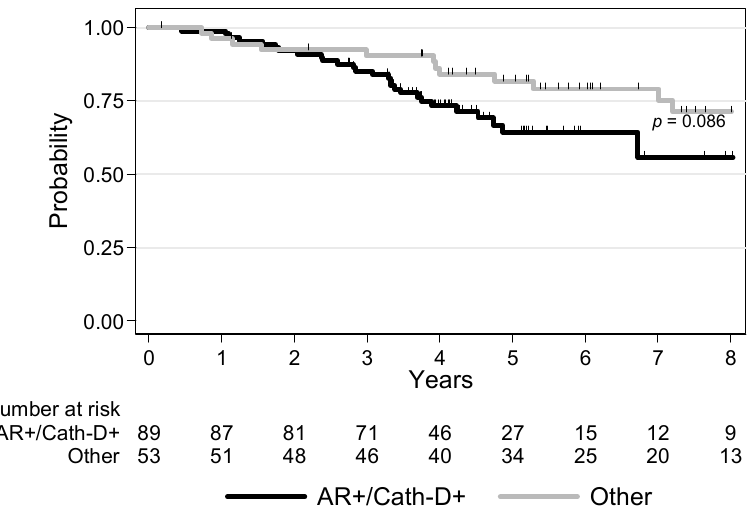
Figure 3. Overall survival in patients with non-metastatic TNBC ( n = 142) in function of AR and Cath-D co-expression.